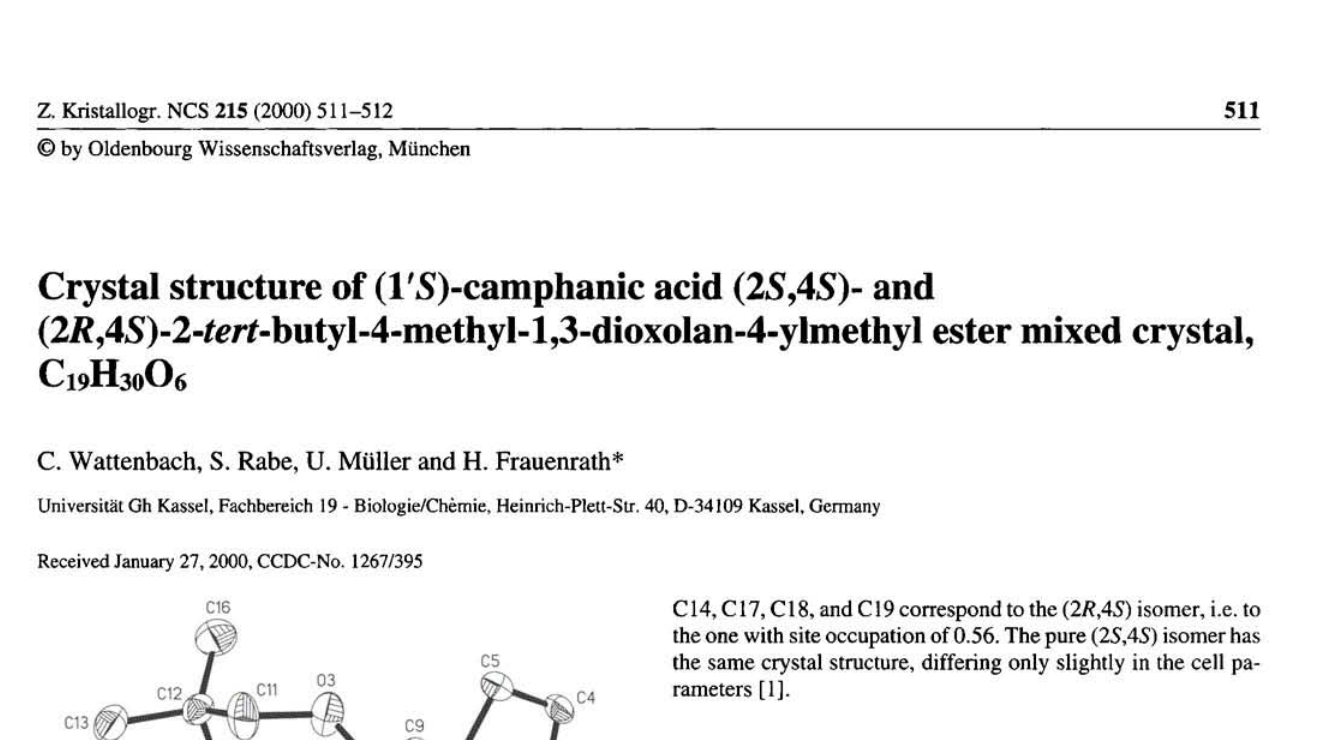
Table 1. Data collection and handling.